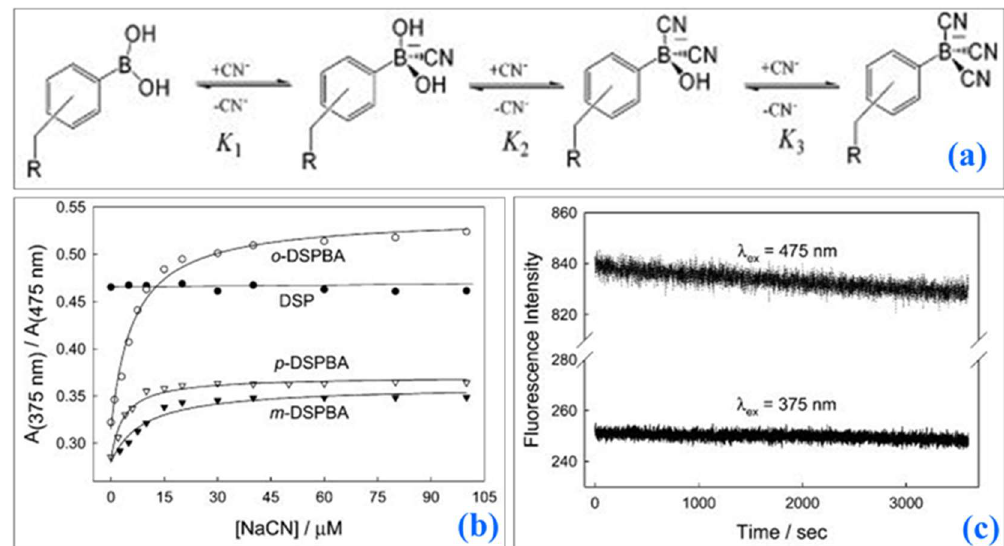
Figure 24. ( a ) Complexation of DSPBA probes with aqueous free cyanide. ( b ) Ratiometric response of the probes in water with increasing cyanide concentrations. ( c ) Fluorescence emission of o-DSPBA in water with time when excited at 475 and 375 nm [70].